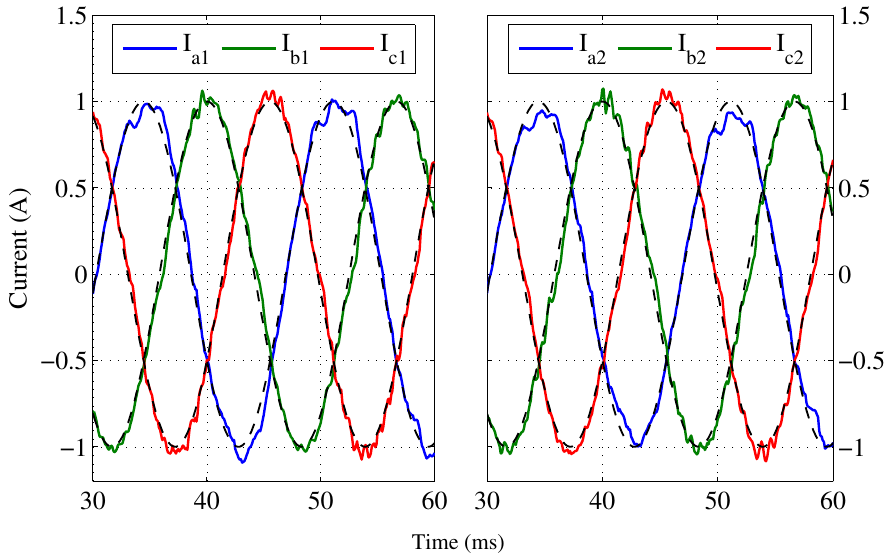
Figure 10. Current controllers output to sinusoidal reference inputs. The currents I b 1 , I b 2 , I c 1 , and I c 2 , have a closed-loop controller, and the currents I a 1 and I a 2 are obtained by the other ones’